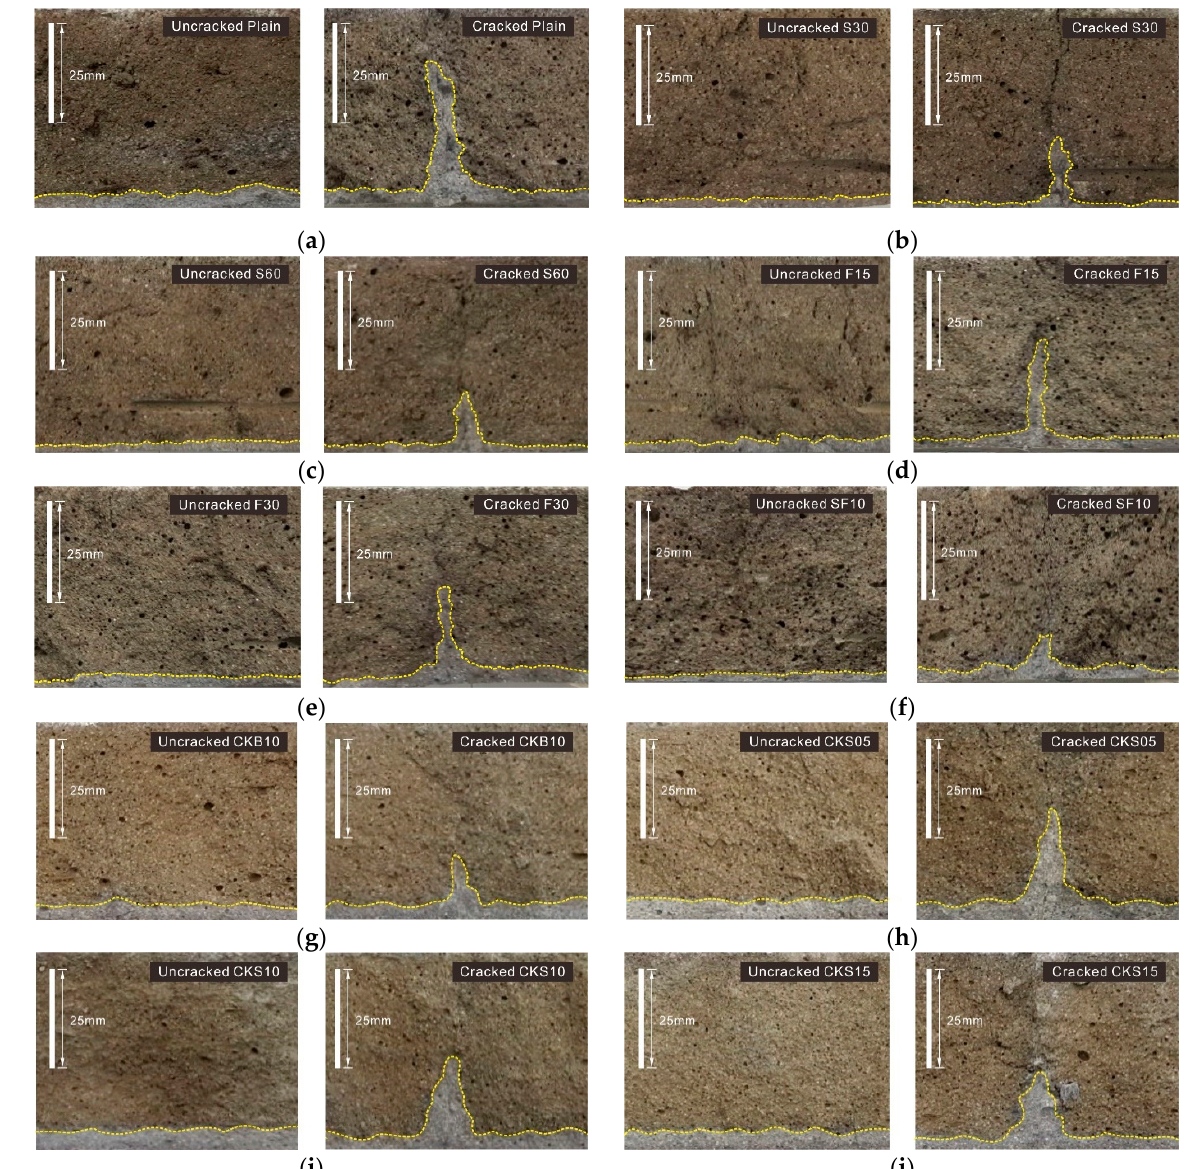
Figure 8. Chloride ion penetration profiles of specimens: ( a ) Plain; ( b ) S30; ( c ) S60; ( d ) F15; ( e ) F30; ( f ) SF10; ( g ) CKB10; ( h ) CKS05; ( i ) CKS10; ( j ) CKS15.